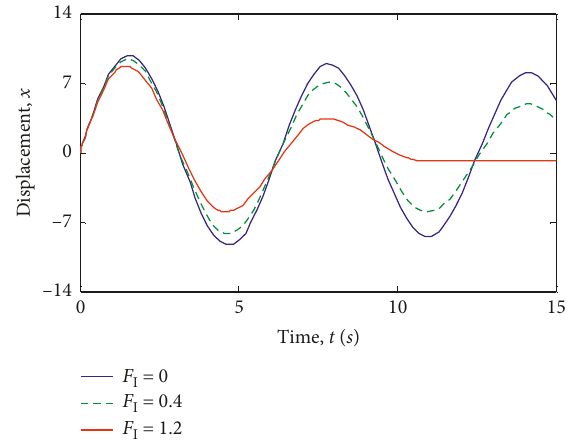
Figure 7: Vibration displacement at F